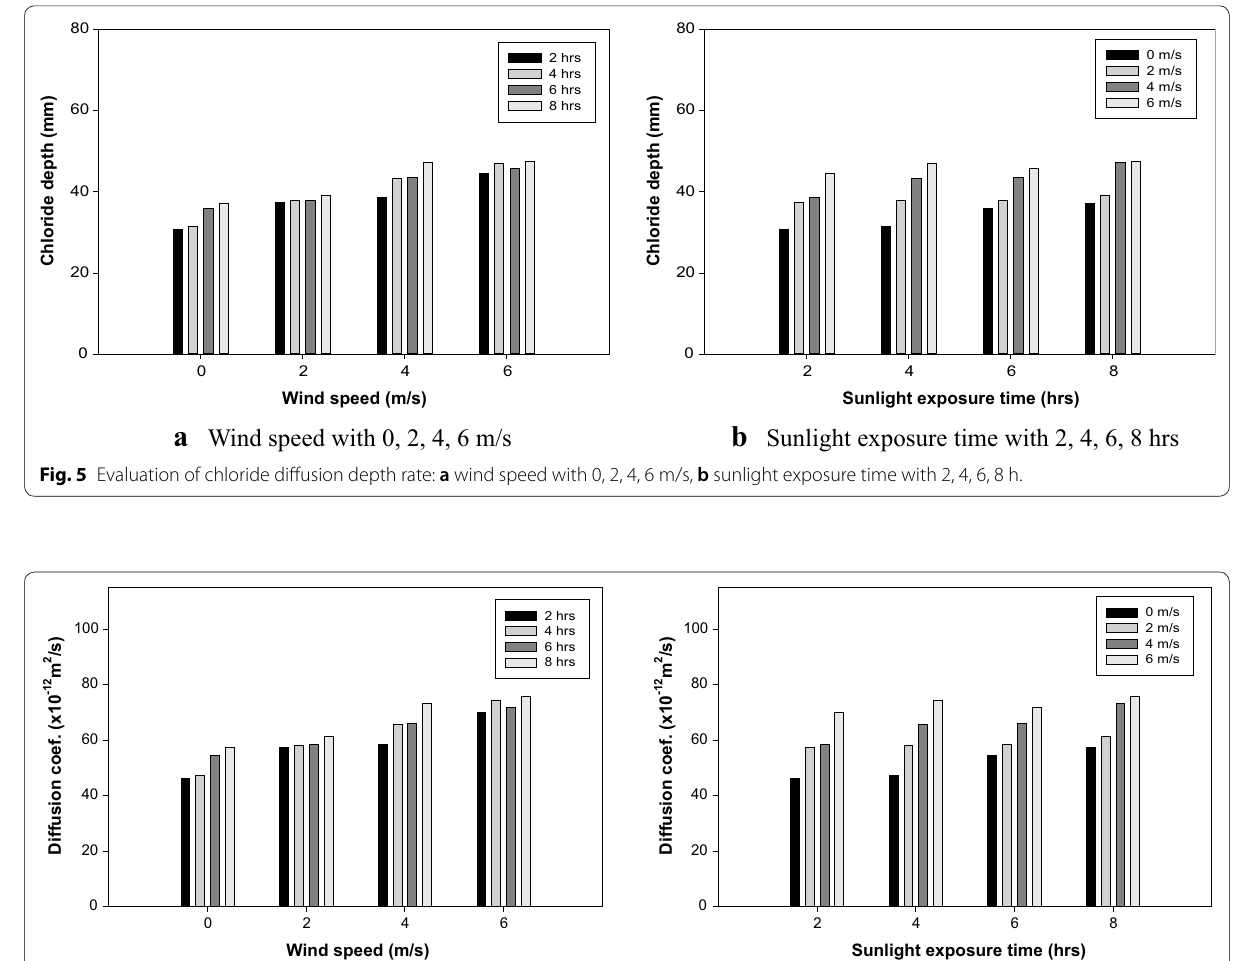
a b Wind speed with 0, 2, 4, 6 m/s Sunlight exposure time with 2, 4, 6, 8 hrs Fig. 6 Evaluation of chloride diffusion coefficient rate: a wind speed with 0, 2, 4, 6 m/s, b sunlight exposure time with 2, 4, 6, 8